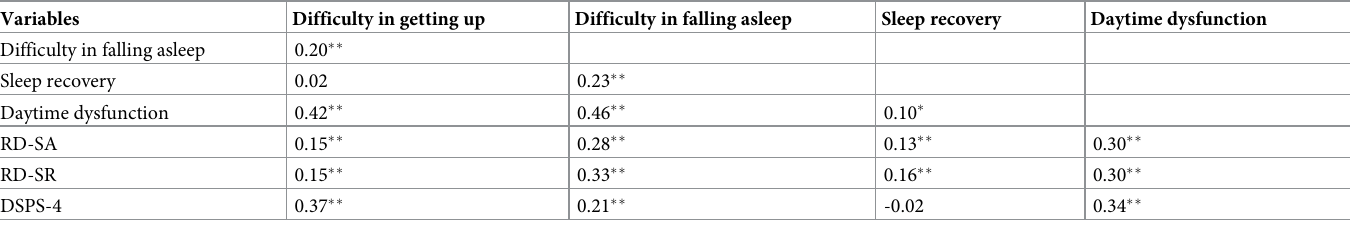
Table 4. Correlations between SQS-C factors, DSPS-4 and driving behaviours ( n =